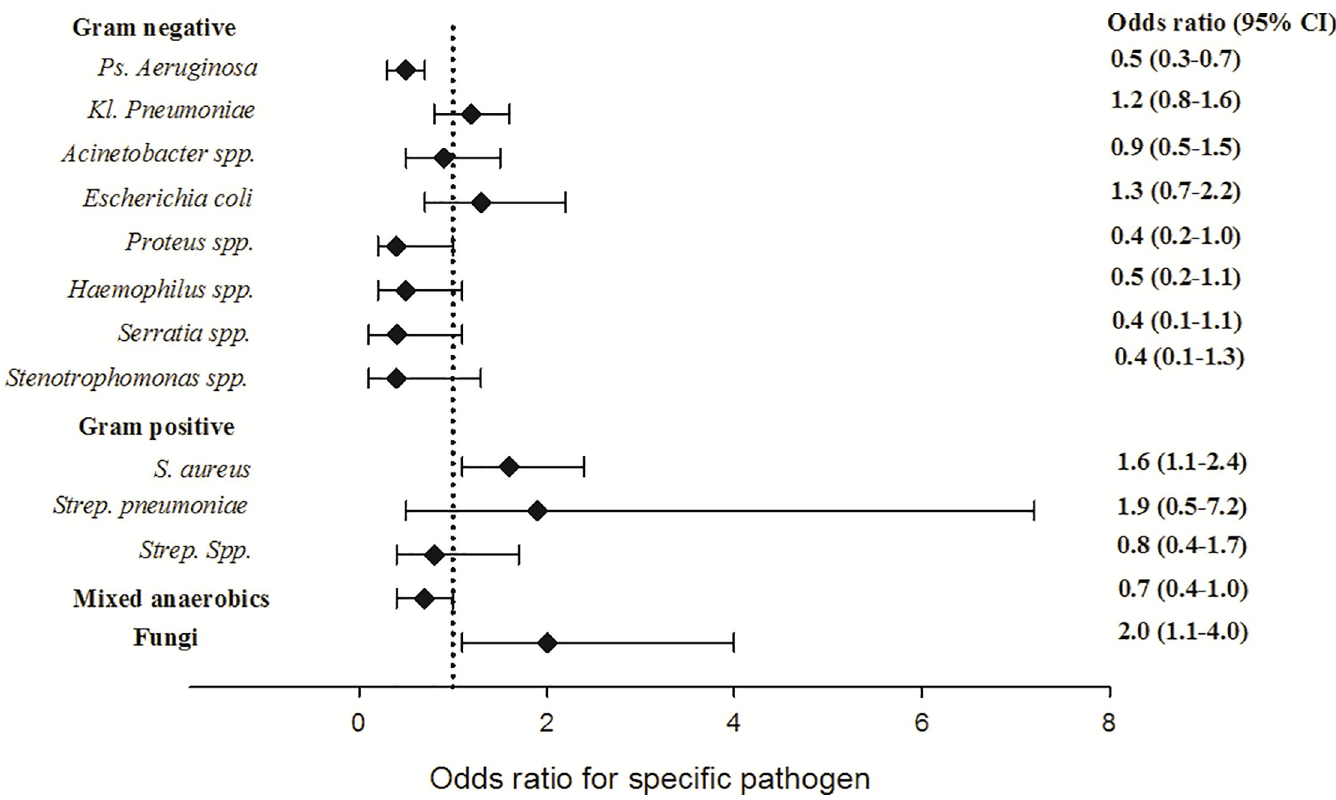
Fig 2. Risk of isolation of specific pathogens in patients with eGFR of < 55.3 mL/min/1.73 m 2 . Odds ratios for specific pathogens were calculated using a multivariate logistic regression model adjusted by age and gender. CI, confidence interval; eGFR, estimated glomerular filtration rate; Ps . aeruginosa , Pseudomonas aeruginosa ; Kl . pneumoniae , Klebsiella pneumoniae ; S . aureus , Staphylococcus aureus ; Strep ., Streptococcus .